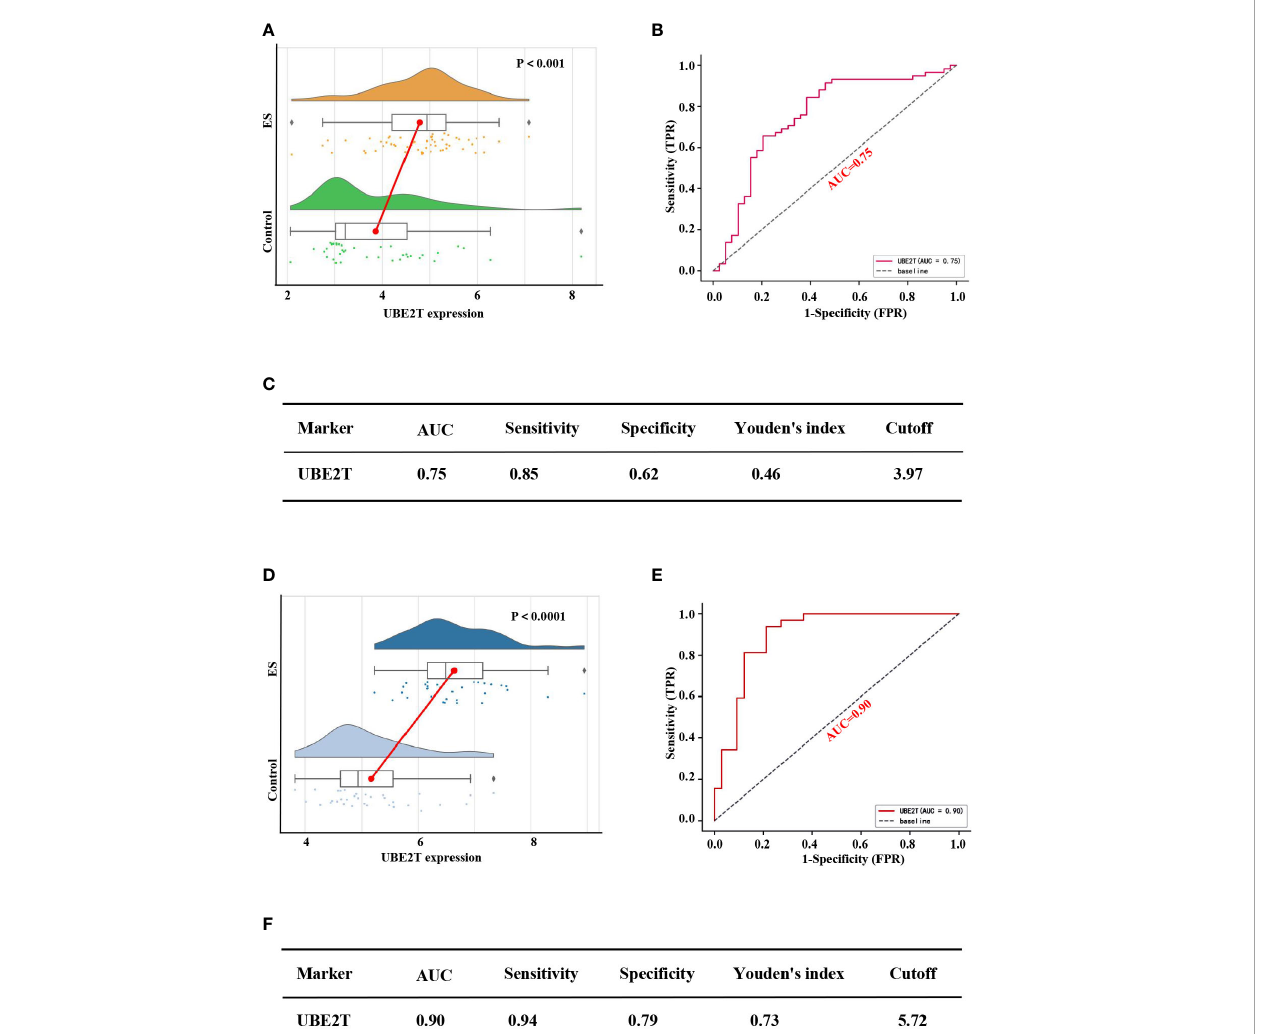
FIGURE 5 Performance of the core gene diagnostic ES in the training and veri fi cation sets. Based on the training set expression pro fi les (GSE17618 and GSE45544): (A) The difference in UBE2T expression between the ES and control groups. (B) The ROC curve of patients with ES based on the UBE2T gene. (C) The diagnostic value of the Core gene in distinguishing the ES group from the control group. According to the validation set expression pro fi le (GSE68776): (D) The difference in UBE2T expression between the ES and control groups. (E) The ROC curve of people with ES based on the UBE2T gene. (F) The diagnostic value of the Core gene in distinguishing the ES group from the control group. AUC stands for Area Under the Curve; TPR stands for True Positive Rate; and FPR stands for False Positive